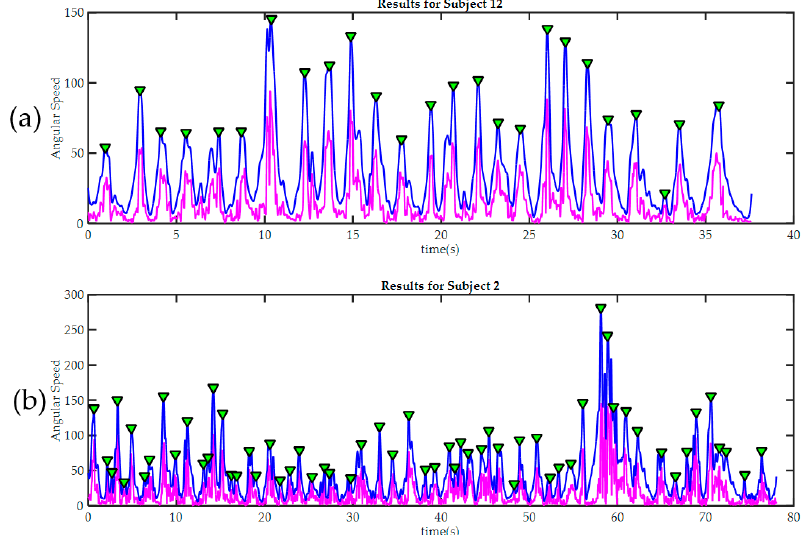
Figure 9. Peak detection results in two trainees during the third exercise. In both cases, the raw signal of magnitude of angular velocity S ω is painted in magenta. The S ω signal after being “smoothed” is painted blue. Detected peaks are marked with green triangles. ( a ) Subject 12, required only 25 movements to finish the third exercise. It can be seen how the good level of manual dexterity is also reflected in the in the smoothness of the signal acquired by the sensors in the glove; By contrast, subject 2 ( b ) made many more moves during the exercise; this was because he made several mistakes and then had to correct them. The significant differences in movement amplitude may indicate poor motor